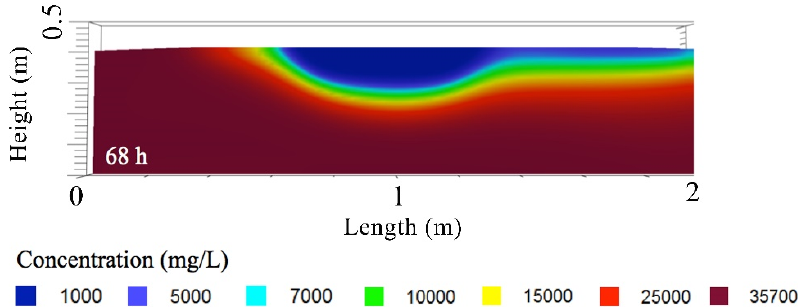
Figure 11. A second recharge pulse is applied to Simulation 2 to show the potential applications for IFL models that consider IFL transient evolution.